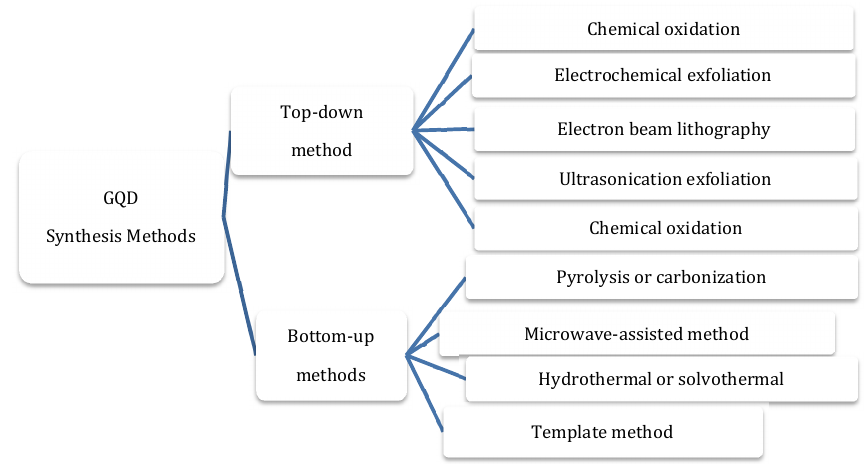
Figure 5. Synthetic approaches for Graphene Quantum Dots (GQDs).